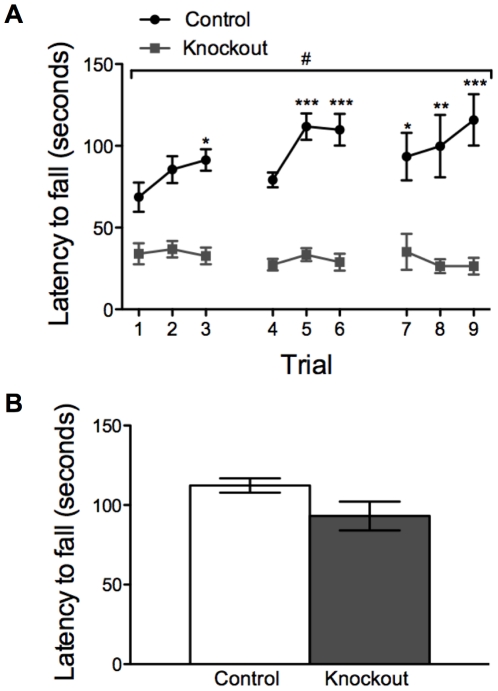
Knockout mice exhibit impaired locomotor learning.(A). Rotarod performance by control (n = 12) and knockout (n = 11) animals across days; two-way, repeated-measures ANOVA: genotype effect F(1, 21) = 70.5, P<0.001; day effect F(8, 168) = 1.63, P = 0.12; genotype x day effect F(8, 168) = 2.37, P = 0.02 (#P<0.05); *P<0.05, **P<0.01, **P<0.001 compared to trial 1 within genotype. (B) Latency to fall during a wire-grip test in control (n = 12) and knockout (n = 11) animals; P = 0.08 by unpaired t test.